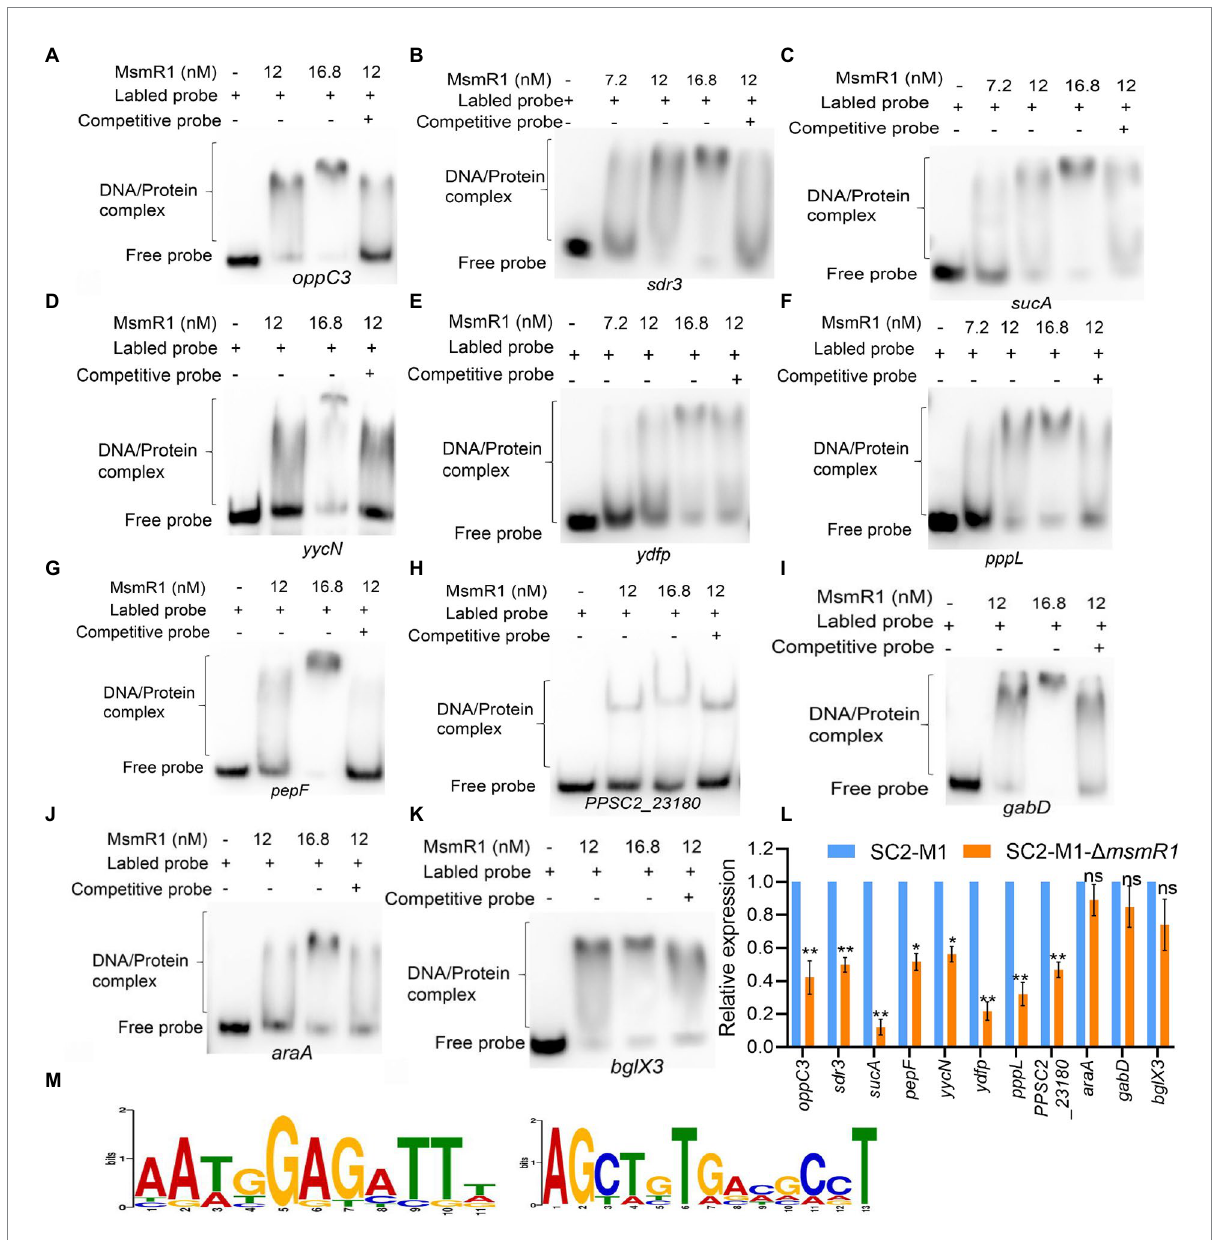
FIGURE 3 Identification of MsmR1 binding genes. EMSA results revealed that MsmR1 could bind directly to the upstream fragment of (A) oppC3 , (B) sdr3 , (C) sucA , (D) yycN , (E) ydfp , (F) pppL , (G) pepF , (H) PPSC2_23180 , (I) gabD , (J) araA and (K) bglX3 . (L) The relative expression of oppC3 , sdr3 , sucA , pepF , yycN , PPSC2_23180 , pppL , ydfp , gabD , araA and bglX3 determined by qRT-PCR. (M) MsmR1 binding motifs identified by MEME analysis. * p < 0.05, ** p < 0.01 and ns, p >